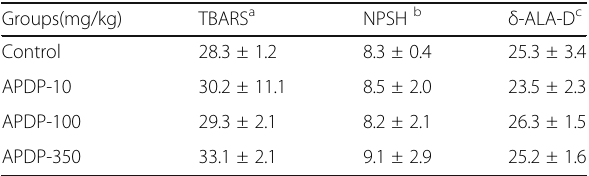
Table 1 Effect of